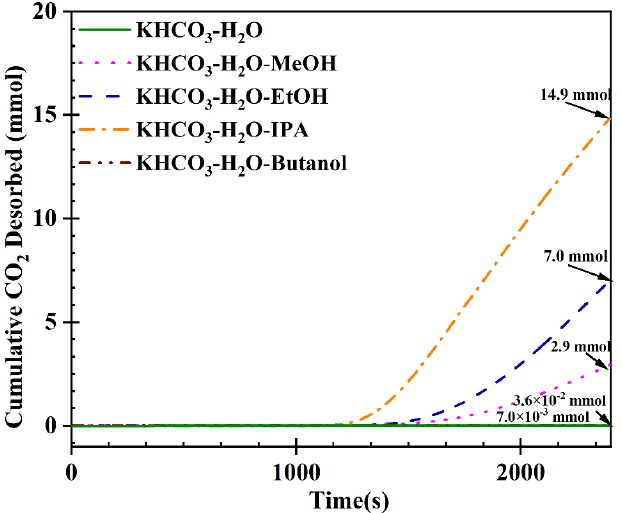
Figure 3. Effect of different alcohols on CO 2 desorption in KHCO 3 − H 2 O and KHCO 3 − H 2 O − alcohol solutions.